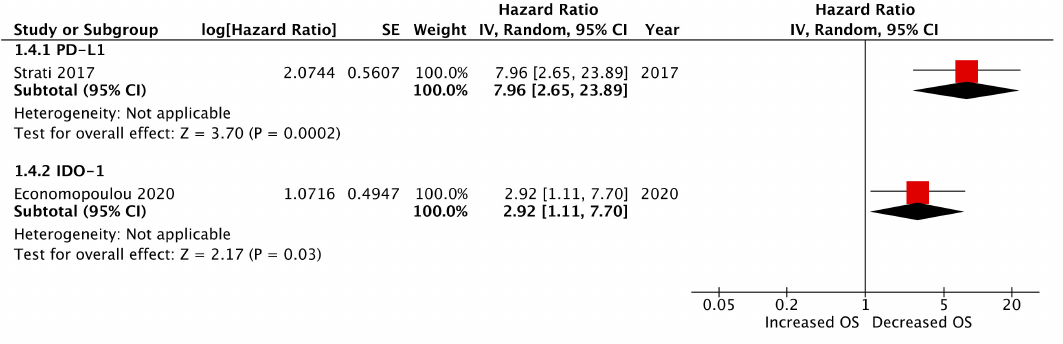
Figure 5. Forest plot of post-treatment CTC immune-marker expression as a biomarker of overall survival (OS) (presented data may vary from Table 2 due to conversion